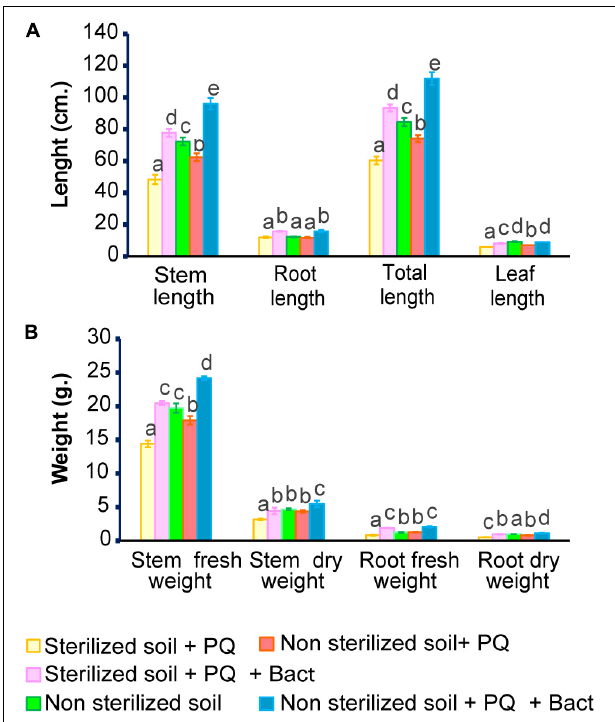
FIGURE 6 | Growth parameters of cowpea ( V. unguiculata ) in soil with/without paraquat. (A) Stem, root, leaf and total length. (B) Fresh weight, dry weight of stem and root.